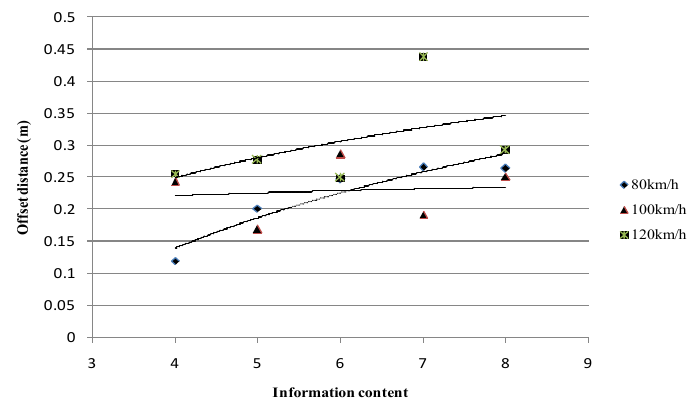
Fig.7. Correlation between driving offset and information content under different driving speeds